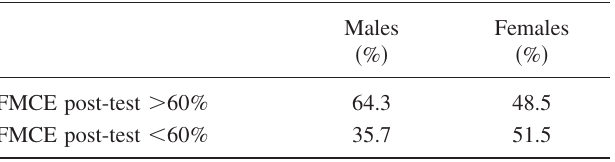
TABLE IX. Percentages of males and females who score above and below 60% on the FMCE post-test. These are the percentages for the sample of 1027 used in the logistic regression analysis. The difference in percentage of males and females that score above and below 60% is significant (cid:1) p (cid:3) 0.01 (cid:2)